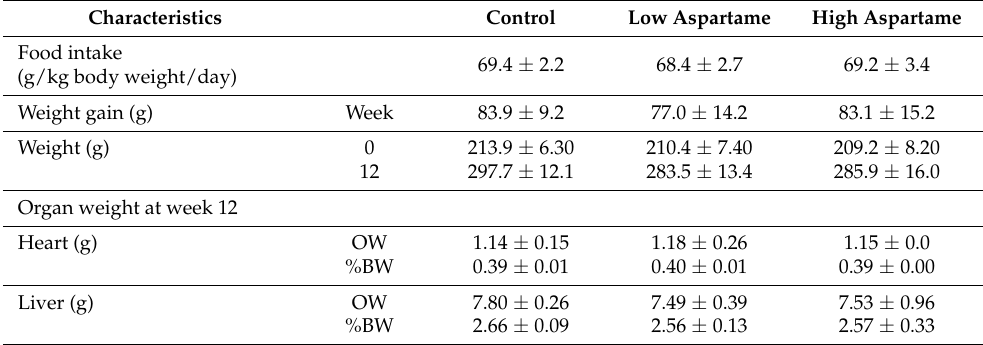
Table 3. Basic characteristics of the three experimental groups (control, low aspartame, and high aspartame) of Sprague Dawley rats at week 0 and